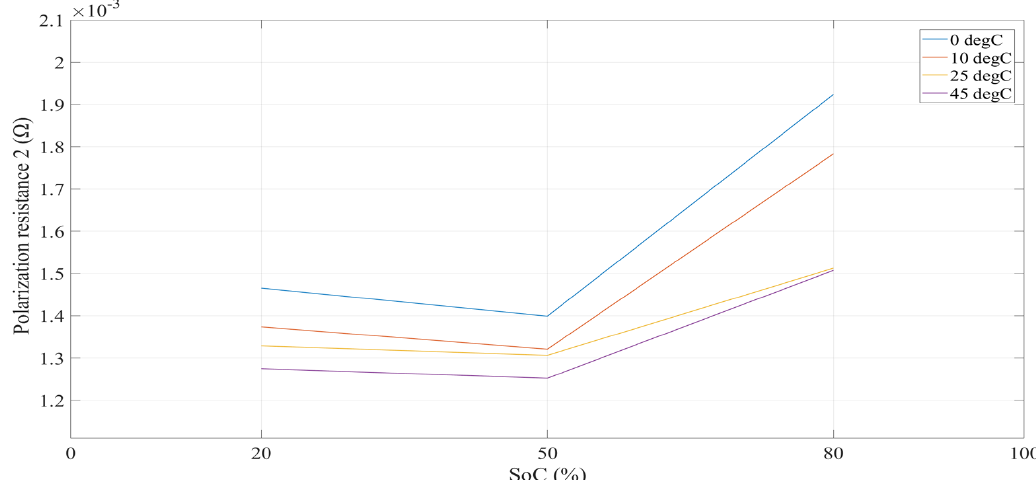
Figure 5. Polarization resistance 1 as a function of temperature and state of charge.